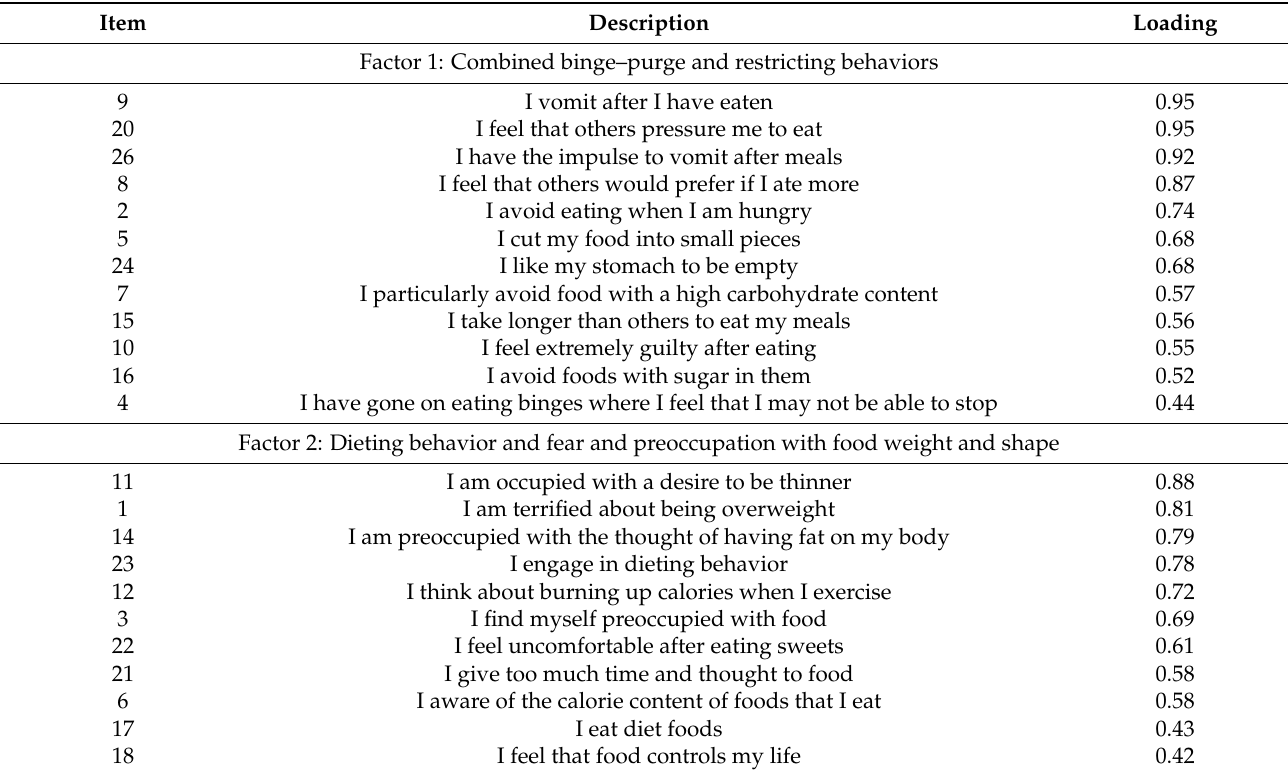
Table 2. EAT-26 factor loadings based on CFA in a nonclinical Israeli Jewish